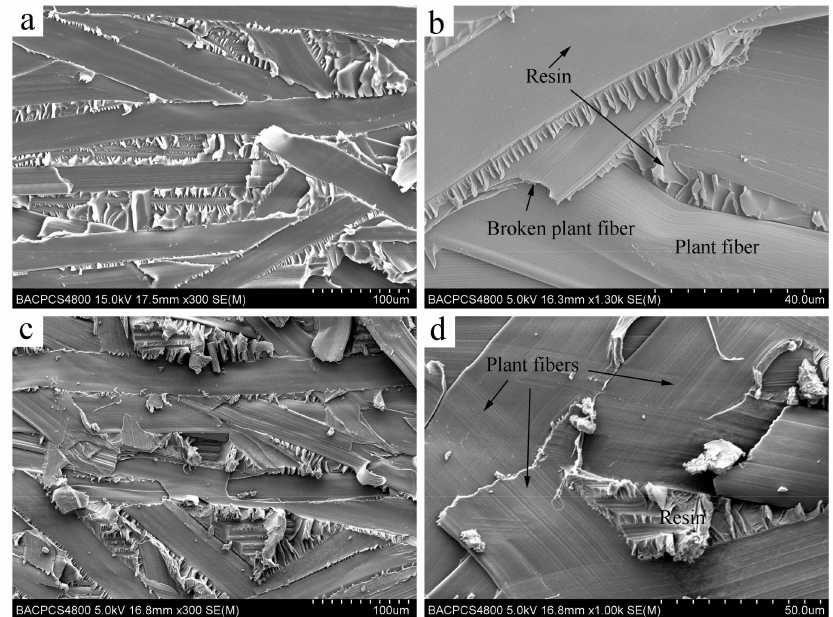
Figure 9. SEM images of Mode II fracture surfaces of ( a , b ) plain papers interleaved composite and ( c , d ) conductive papers interleaved